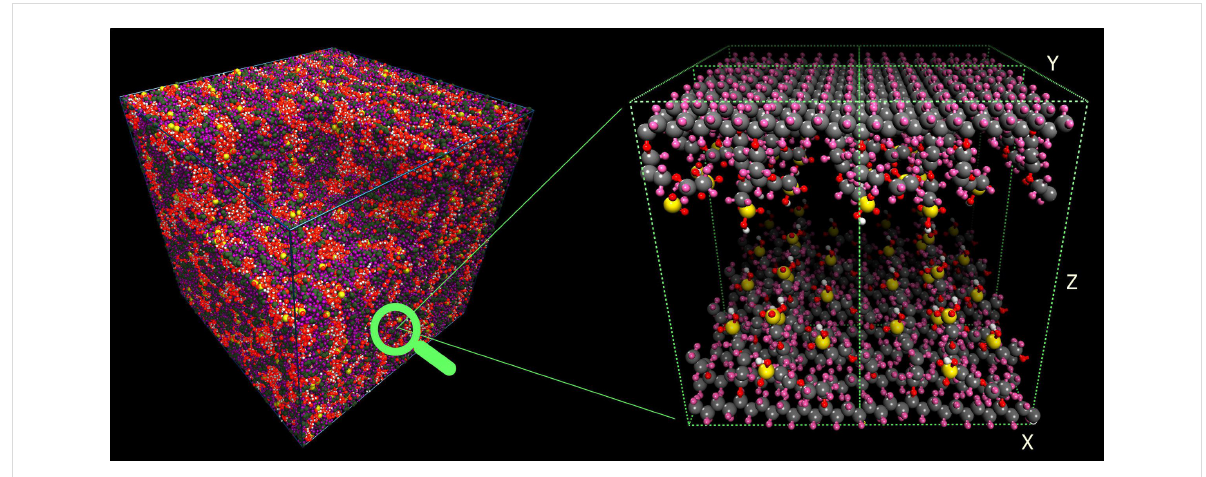
Figure 10: Model of the ion-conducting channel studied by quantum molecular dynamics. The initial configuration is shown. Channel walls are formed by Nafion chains oriented along the X -axis. The chains are infinite in the periodic cell. The total number of atoms in the system is 1200. Water mole- cules filling the channel are omitted for visual clarity. Conventional atom colors are